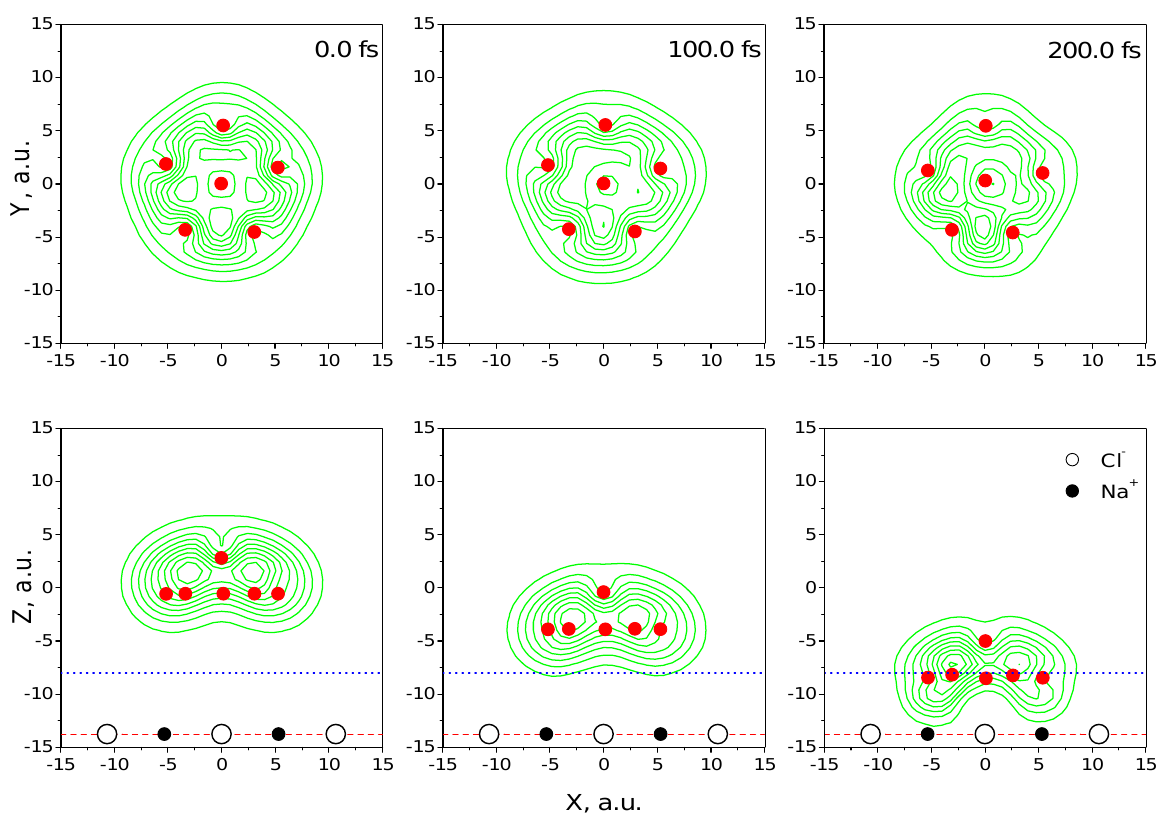
Figure 4: Electron charge density and ionic positions for the Na different time of deposition for an initial kinetic energy kinetic energy 6.9